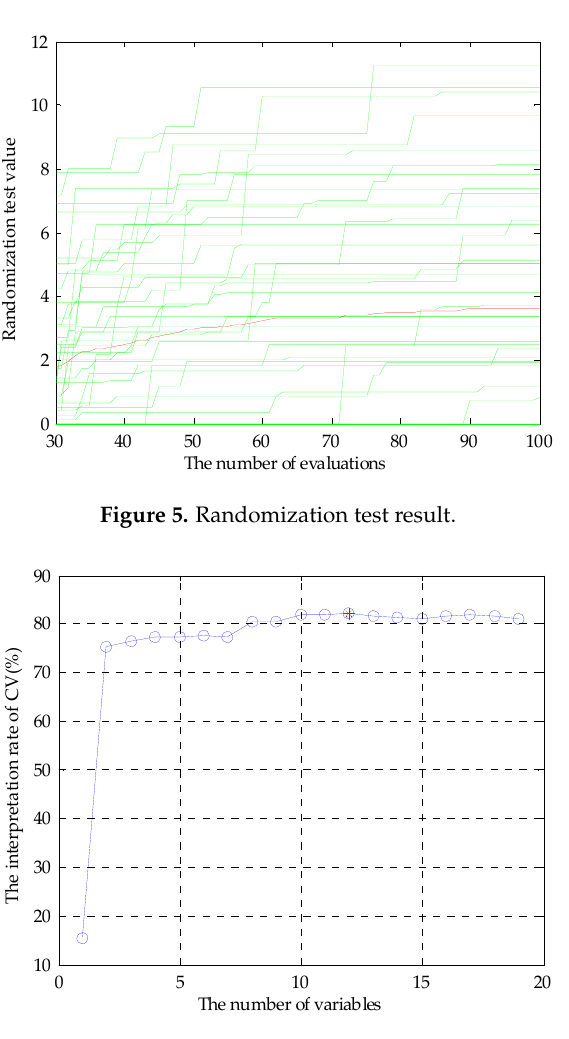
Figure 6. CV% change curve.